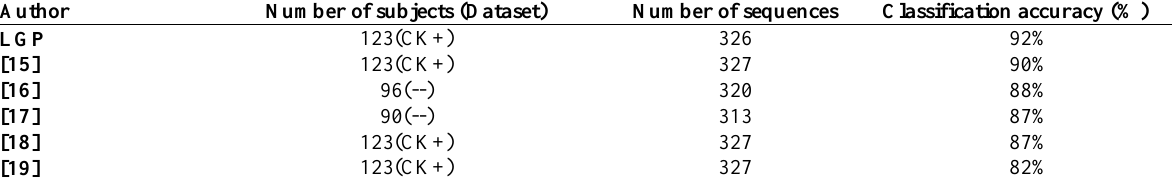
Table 5. Comparison with Different Approaches, Number of expression classes=7 and non-dynamic.